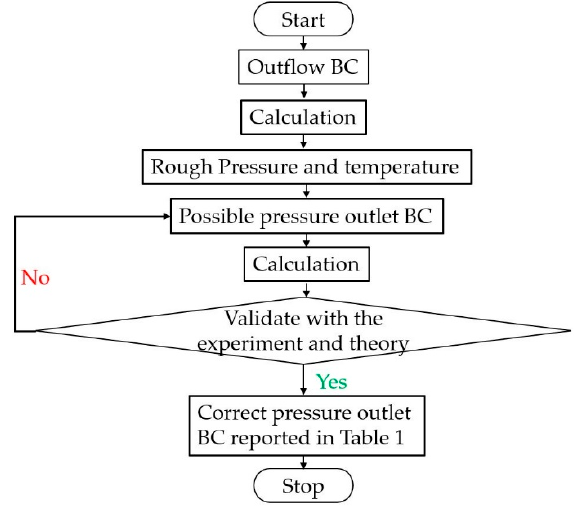
Figure 10. The pre-simulation technique. Table 2. The FEA settings.